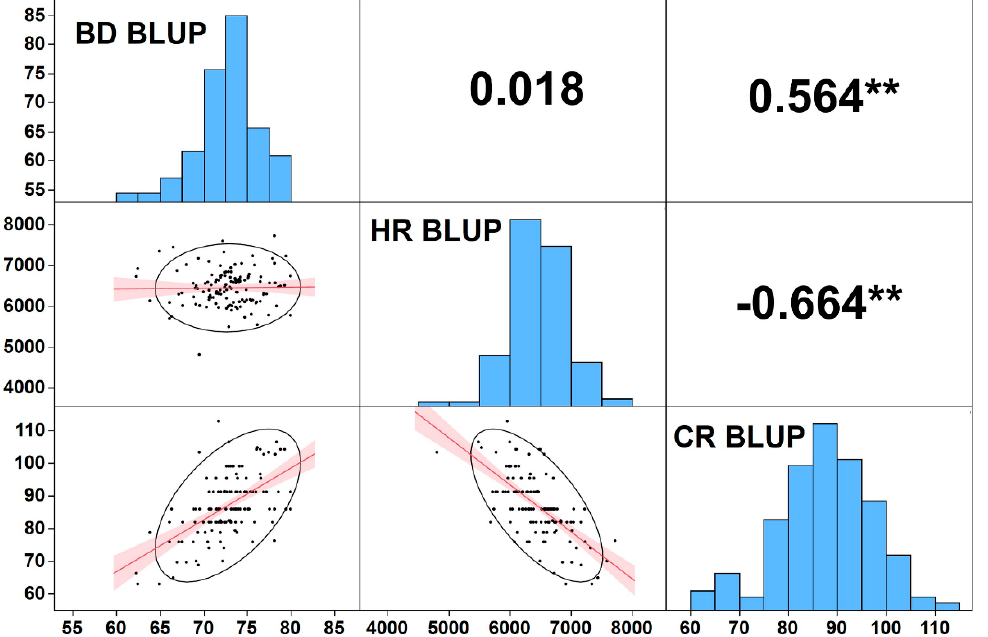
Figure 3. Correlation between bloom date (BD), heat requirement (HR) and chill requirement (CR) in the U.S. peach germplasm using the best linear unbiased prediction (BLUP) values of eight analyzed years (2014–2021). Asterisks indicate Pearson correlation coefficient at significance level of p < 0.05 (*) and p < 0.01 (**).